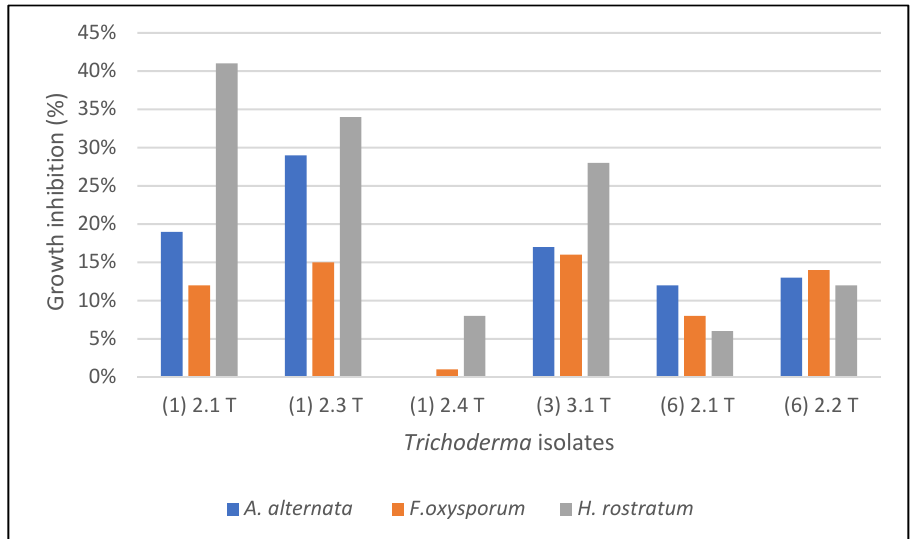
Figure 1. Effect of volatile metabolites of Trichoderma on the growth of plant pathogenic fungi. The result on the effect of culture filtrate of Trichoderma spp. on the plant pathogenic fungi reveals that most of the Trichoderma isolates were able to inhibit the growth of the pathogens. The highest inhibition in the growth of A. alternata (29%) was recorded by the culture filtrate of Trichoderma (A (1) 2.3 T). As for the F. oxysporum , the highest percentage of growth inhibition (16%) was achieved by the Trichoderma (A (3) 3.1 T). The culture filtrate of Trichoderma (A (1) 2.1 T) inhibited the maximum growth of H. rostratum (41%) (Figure 2).